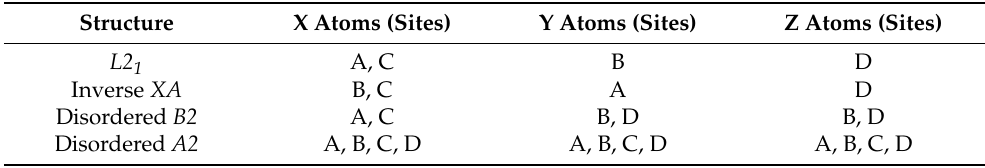
Table 1. Sites associated withX, Y, and Z atoms for the different austenitic phases of Heusler ‐ type stoichiometry alloys.